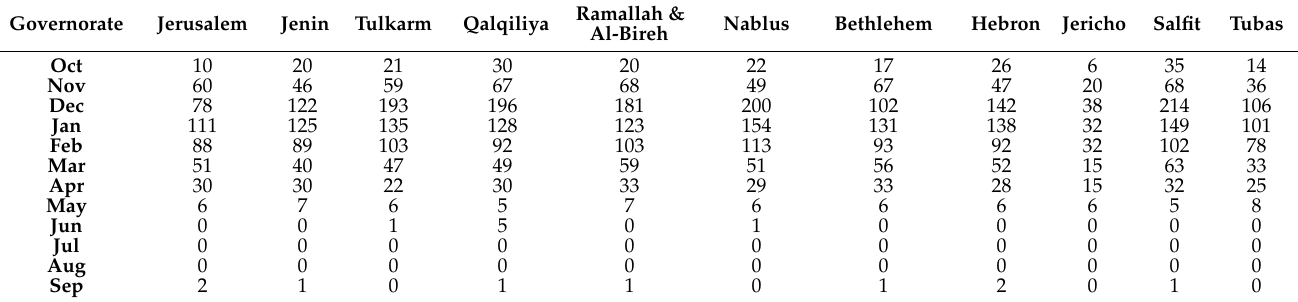
The average monthly (all governorates, Table 1) and daily (Nablus governorate, Table 2) rainfall data for some selected rainfall stations (presented in Figure 1) for the period (2013–2019) were obtained from the Palestinian Metrological Department [42]. Table 1. The average monthly rainfall (mm) in the different West Bank governorates for the period (2013–2019). Governorate